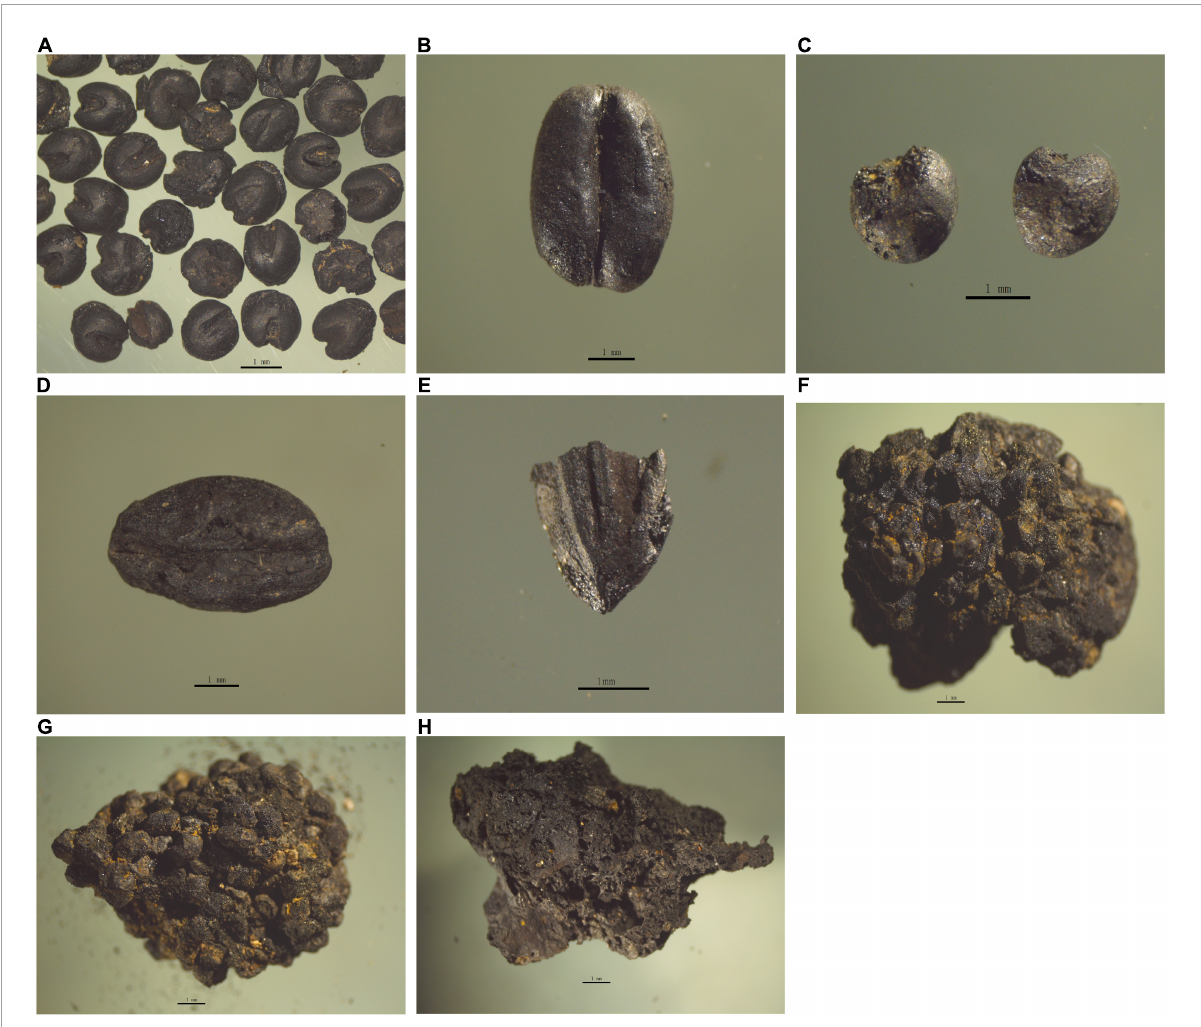
FIGURE4 Domestic crops recovered from ZKS site. (A) Foxtail millet; (B) wheat; (C) broomcorn millet; (D) hulled barley; (E) rice; (F–H) boiled plant containing foxtail millet